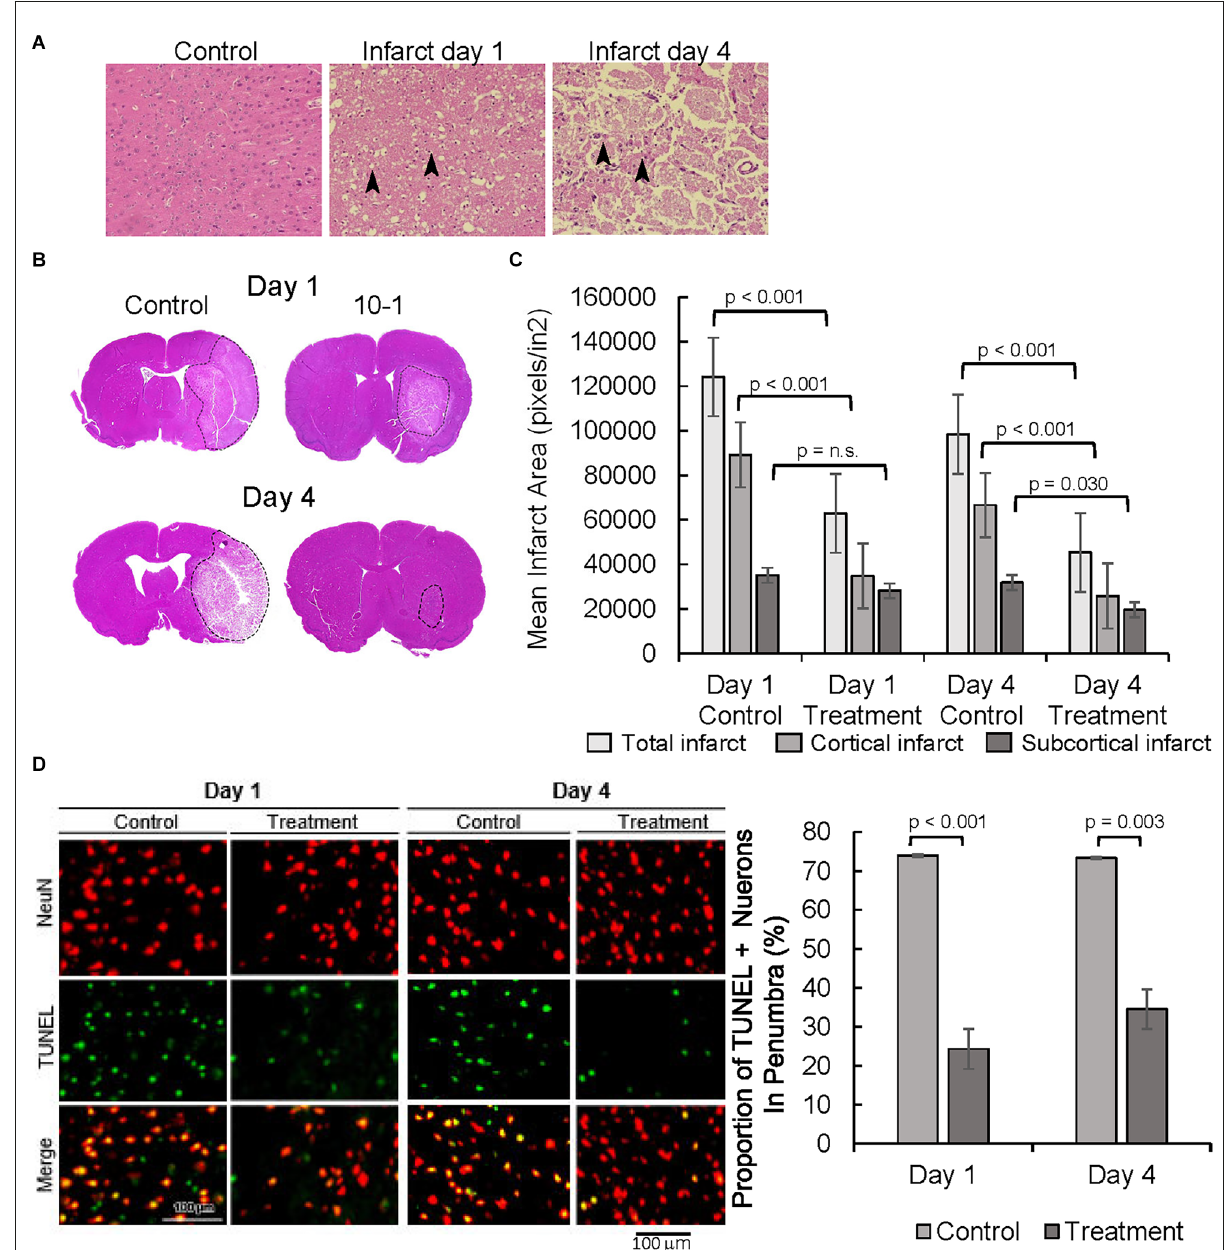
FIGURE2 10-1 treatment attenuates progression of tissue damage post-MCAO R. (A) H&E tissue sections from the contralateral side (control, 1 day post- MCAO) and infarct areas at day 1 and day 4. Arrows indicate areas containing darkly stained pyknotic nuclei, cell body shrinkage, perineuronal vacuolization, and granular necrotic debris. (B) Representative H and E sections day 1 and day 4 post-MCAO. (C) Cortical and sub-cortical infarct size were measured in H&E stained brain tissue sections 1 day and 4 days post-MCAO R. (D) Representative images of TUNEL and NeuN immunostaining showing neuronal apoptosis one and 4 days post-MCAO R. Quantification of TUNEL positive NeuN positive cells. Day 1 and day 4 n = 10 control, 10 drug-treated, three images per